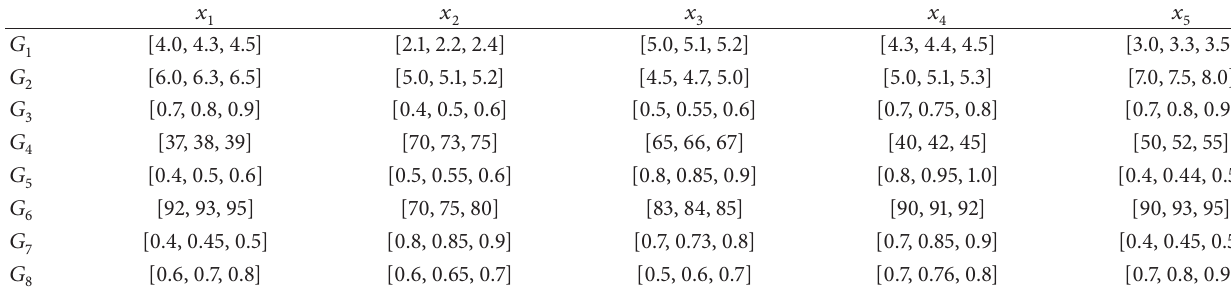
Table 2: Triangular fuzzy number decision matrix 𝐴 (2) .